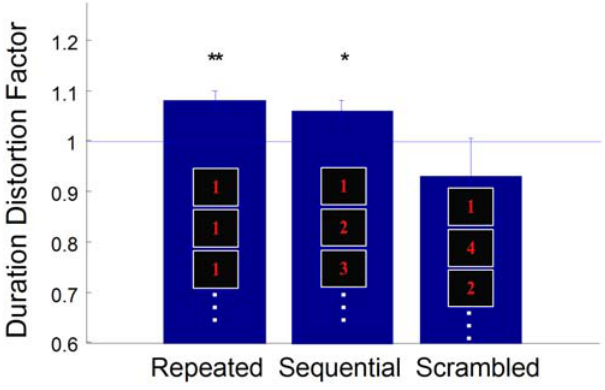
Figure 5. Prediction at higher versus lower levels. Participants made duration discriminations about the first stimulus in a series of repeated, sequential or scrambled number sequences. Both repeated and sequential images had significant duration distortions (p , 0.005 and p , 0.03, respectively). This distortion was absent in scrambled sequences. Error bars SEM.